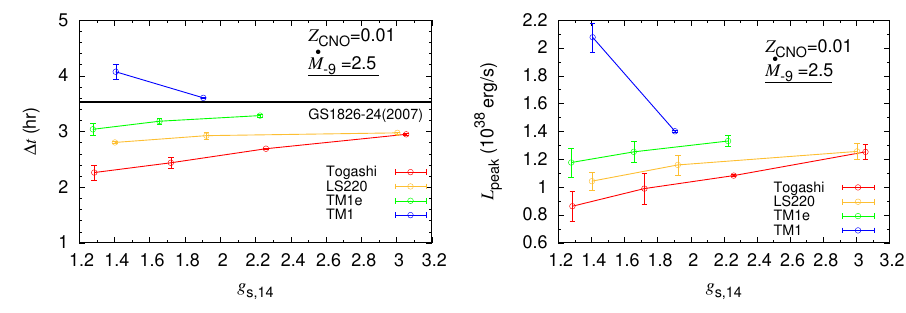
Figure 2. ∆ t and L peak plotted by g s , 14 with di ff erent EOSs. The horizontal solid line corresponds to the observed value of GS 1826–24 in 2007 [17]. Some burst models are omitted if hydrostatic equilibrium conditions are not